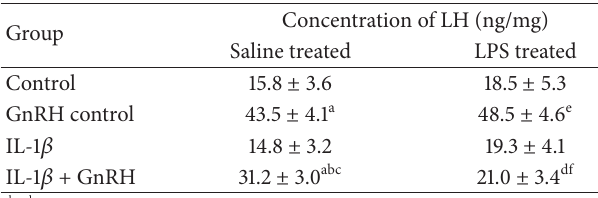
Table 1: Summary release of LH from the AP explants collected from saline and LPS-treated ewes during the 3 h incubation